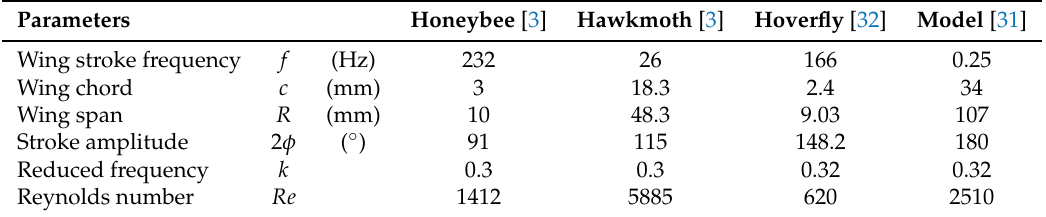
Table 1. Wing parameters of three flying insects and the scaled model submerged in water with